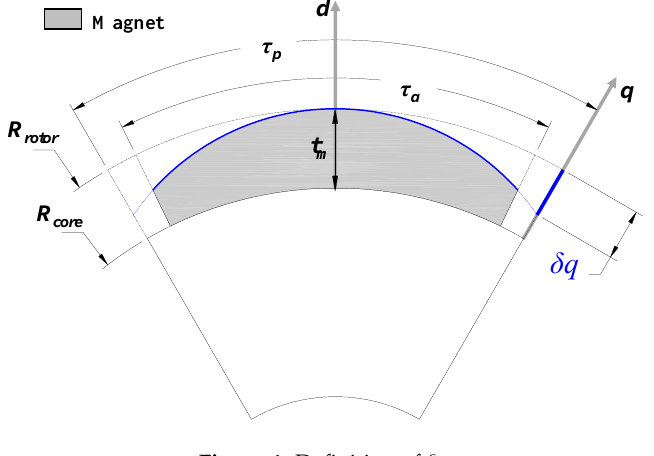
Figure 4. Definition of δq .